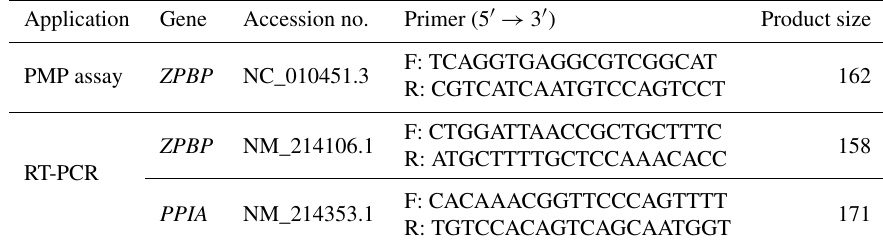
Table 1. Primer sequences used for PMP assay and RT-PCR.